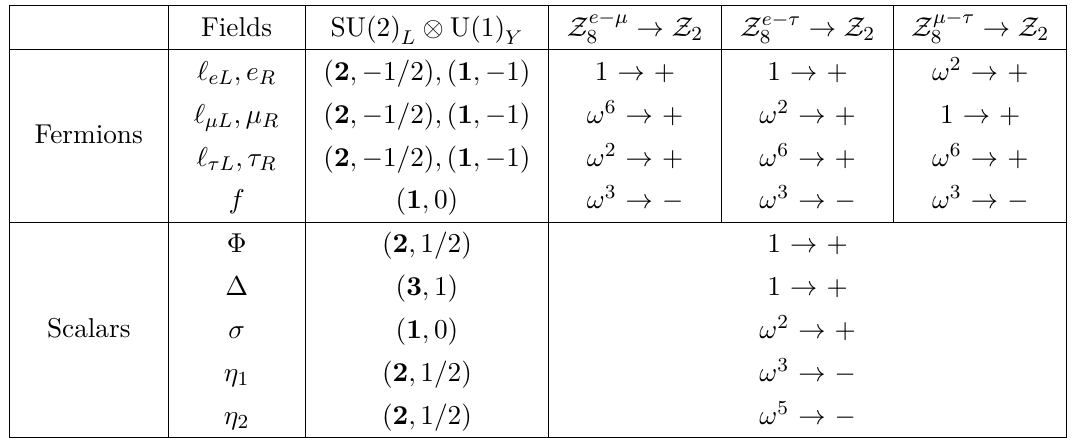
Table 1 . Field content of the model and corresponding transformation properties under the SU(2) gauge group. For the Z ⊗ U(1) L Y